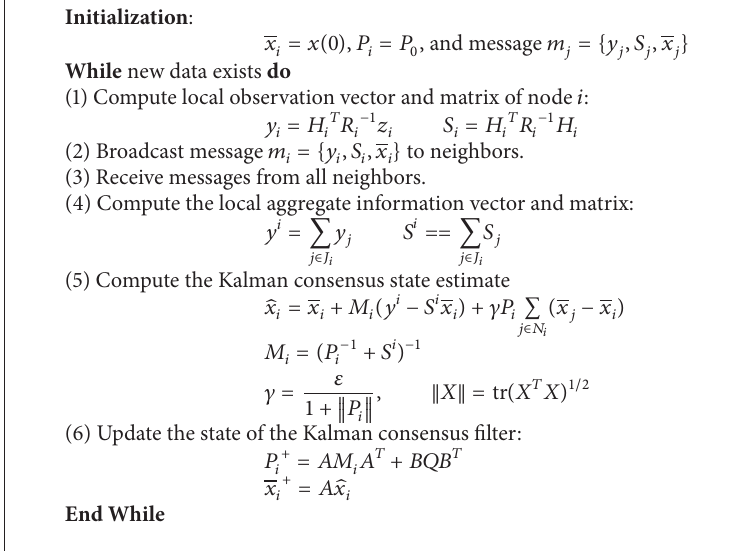
Algorithm 2: Suboptimal Kalman consensus filter: DKF Algorithm with an estimator that has a rigorously derived consensus term (message passing during one time cycle for